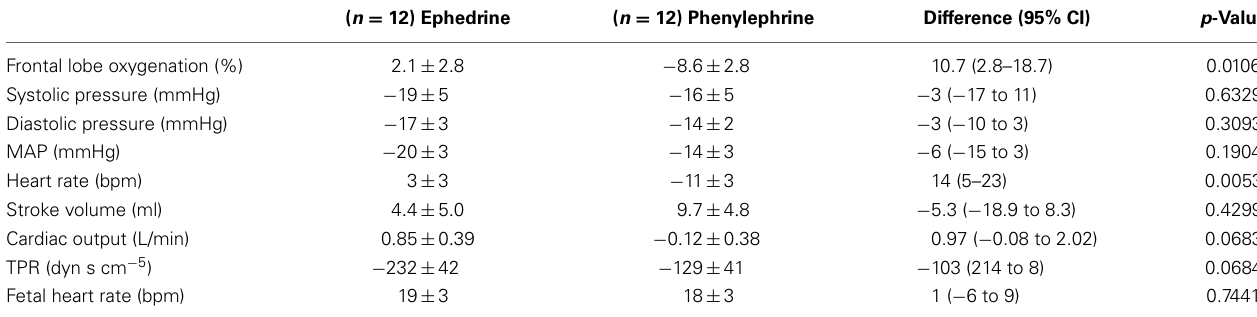
Table 2 | Change in outcomes from baseline on average during 60min trial period, in patients randomized to either ephedrine or